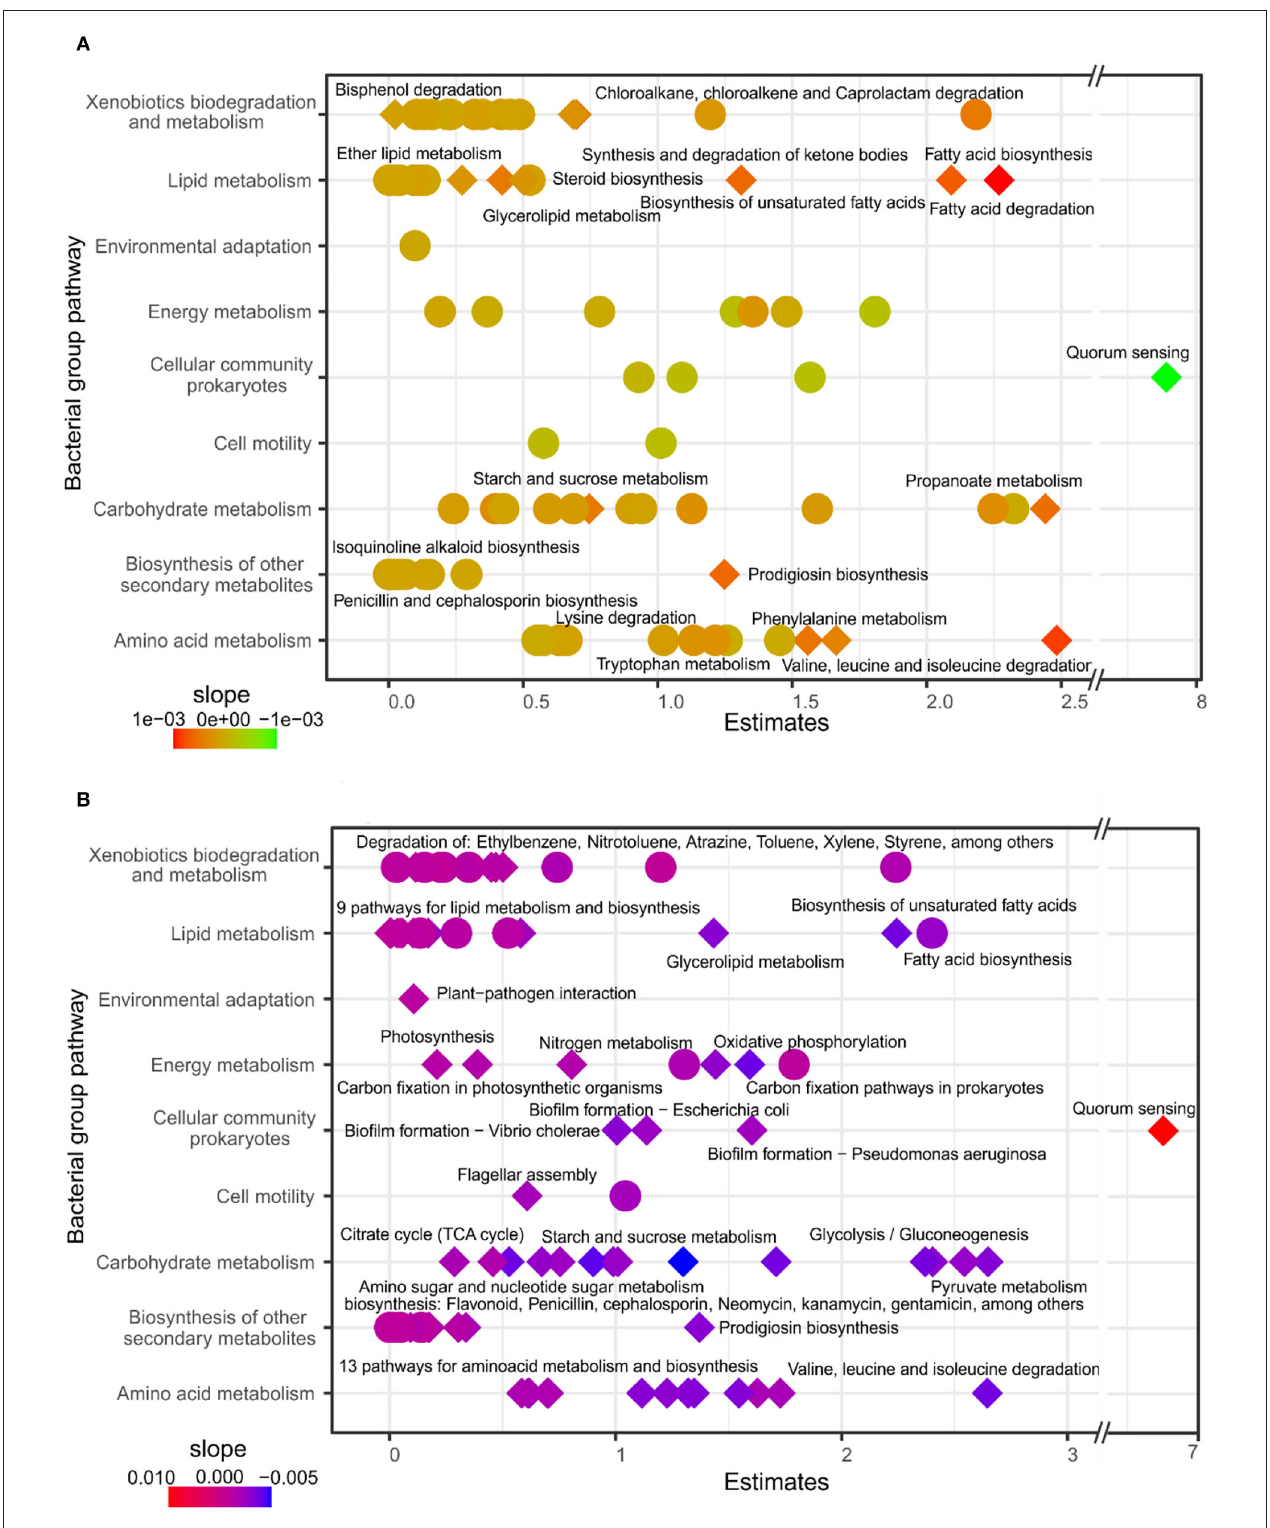
FIGURE 3 | GLM of bacterial pathways related to evergreen tree proportion (A) and soil depth (B) . Estimates are the intercept of the model and the color represents the slope. Diamonds represent specific pathways that respond with significant differences according to ANOVA ( p < 0.05) of the GLM. Pathways with significant effects in relation to evergreen tree proportion and soil depth were labeled with specific pathways (Level 2), and model details are provided in Supplementary Tables 7 , 8 .